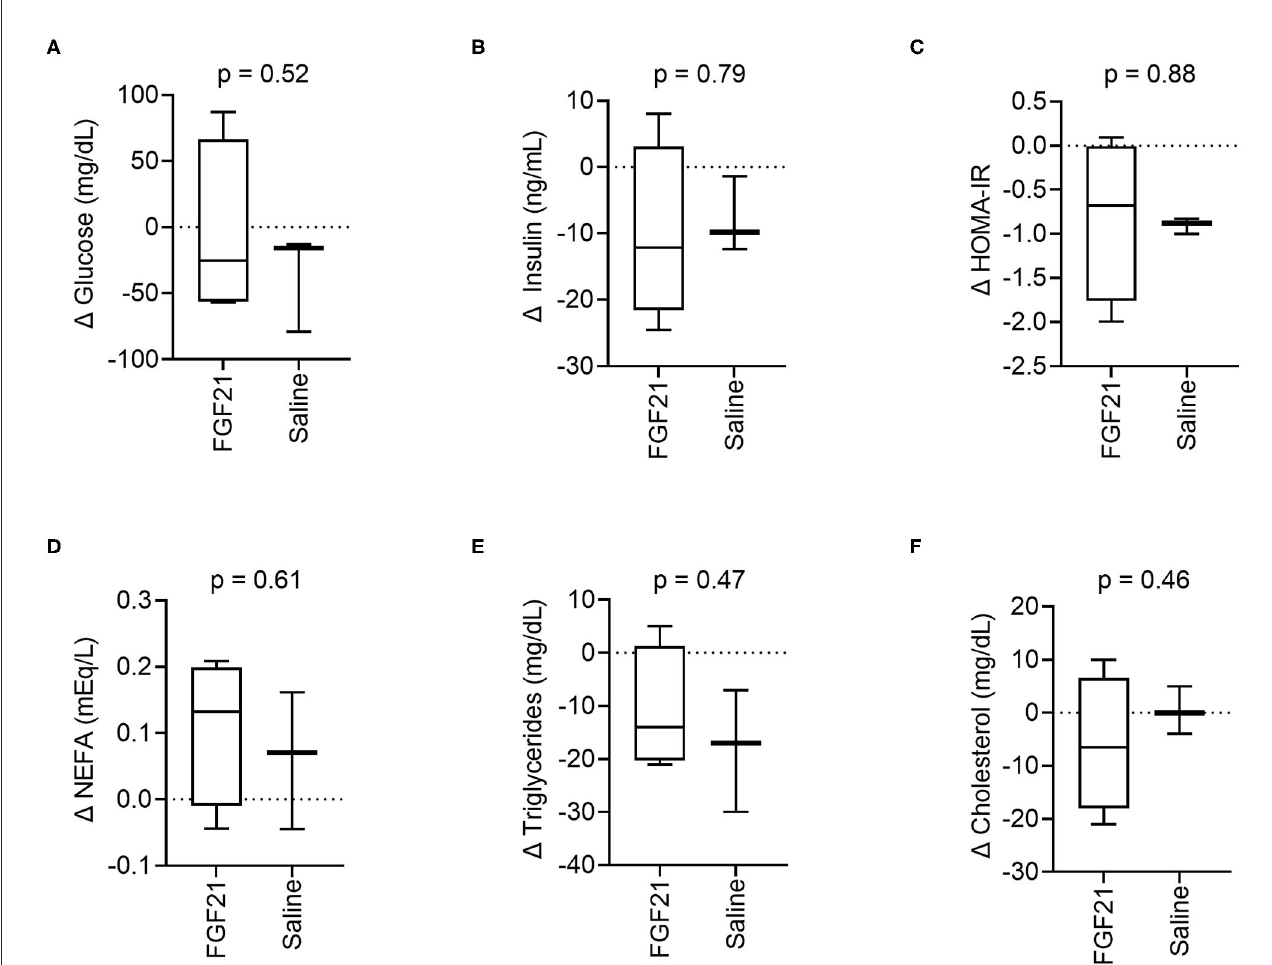
(Figure 3D). There was no difference in change in liver elasticity between treatment and controls ( p = 0.16, Figures 3C,